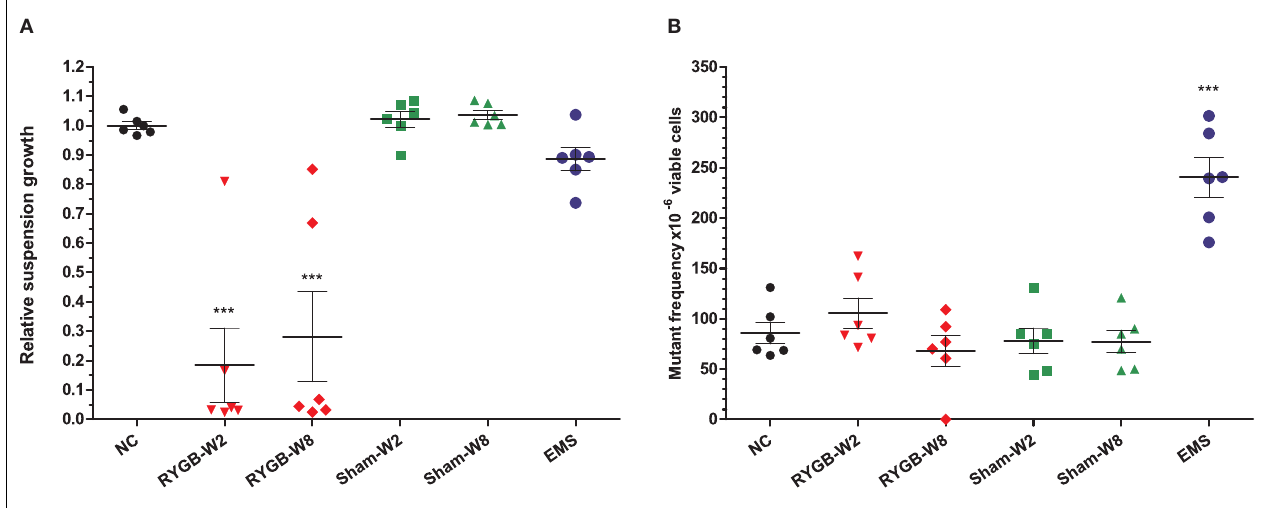
represent mean ± SEM of six independent samples.The negative control (NC) replaced fecal material with water and EMS (20 μ g/ml) was used as a positive